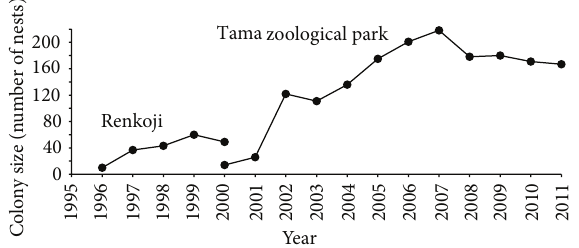
Figure 1: Yearly changes in the number of nests in the Renkoji and Tama Zoological Park colonies. In 2000, the Renkoji site was abandoned, and a new colony was established at the Tama Zoological Park close to